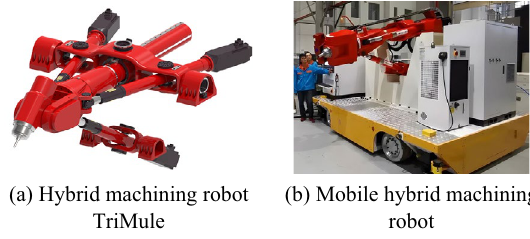
Figure 20 Metrom milling robot